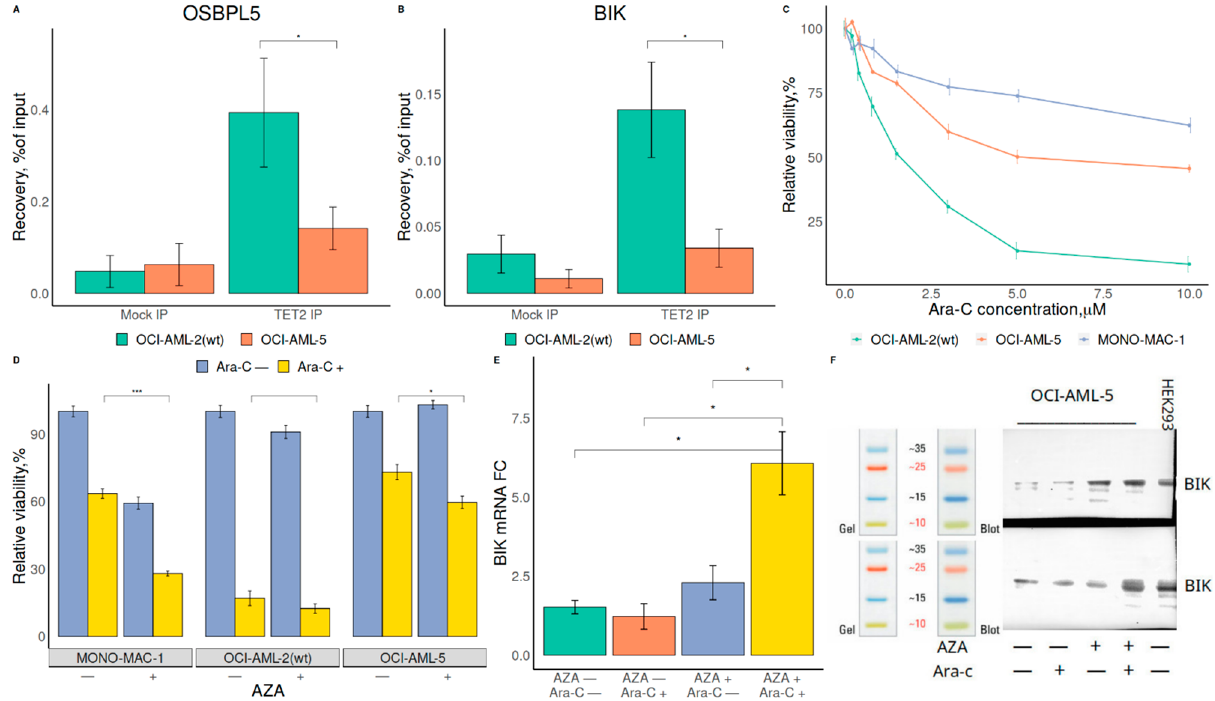
Figure 2. ( A,B ): TET2 binding (ChIP-qPCR) in OSBPL5 ( A ) and BIK ( B ) gene in OCI-AML2 cells (wt RUNX1) and in OCI-AML5 (mutated RUNX1). Significant differences ( p -value < 0.05) are marked with *. ( C ) Effect of Ara-C on viability of the AML cell lines with and without RUNX1 mutations. ( D ) Effect of the demethylating agent AZA in combination with Ara-C on the viability of AML cell lines with and without RUNX1 mutations. Significant differences ( p -value < 0.05 and p -value < 0.0005) are marked * and *** respectively. ( E,F ): Expression of BIK in RUNX1-mutated OCI-AML5 cells before and after treatment with AZA and Ara-C: mRNA level ( E ) and protein level ( F ).